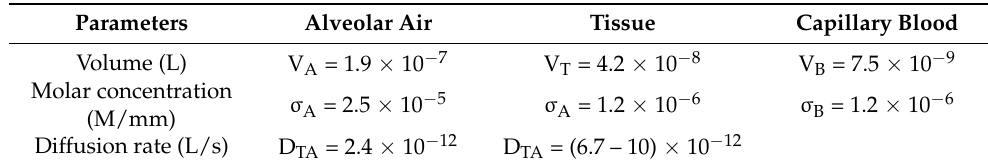
Table 3. Parameters values of the gas exchange model.